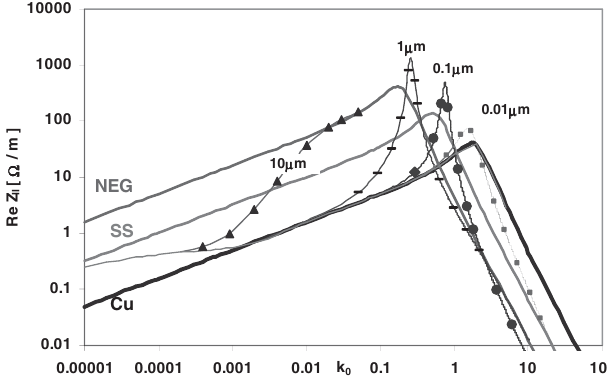
FIG. 5. Three-layer tube longitudinal monopole impedance for various NEG-layer thickness. Copper layer thickness is 1 (cid:1) m .